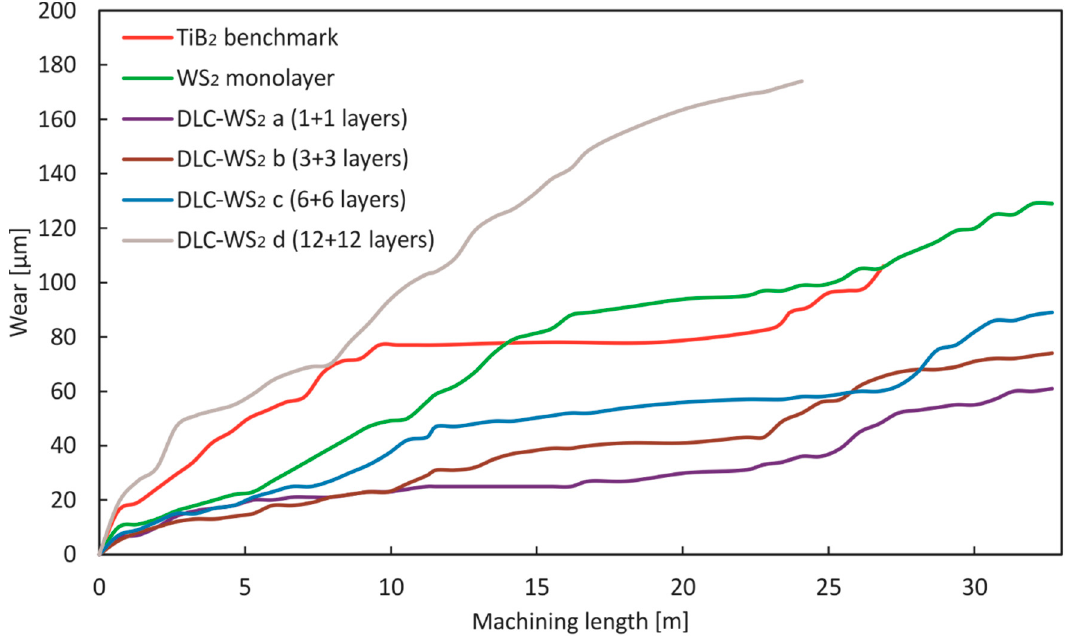
Figure 9. Tool wear curves of KC410M milling inserts with DLC-WS 2 coatings (cutting parameters: V c : Figure 9 500 m/min, a p = 10 mm, f t : 0.05 mm).